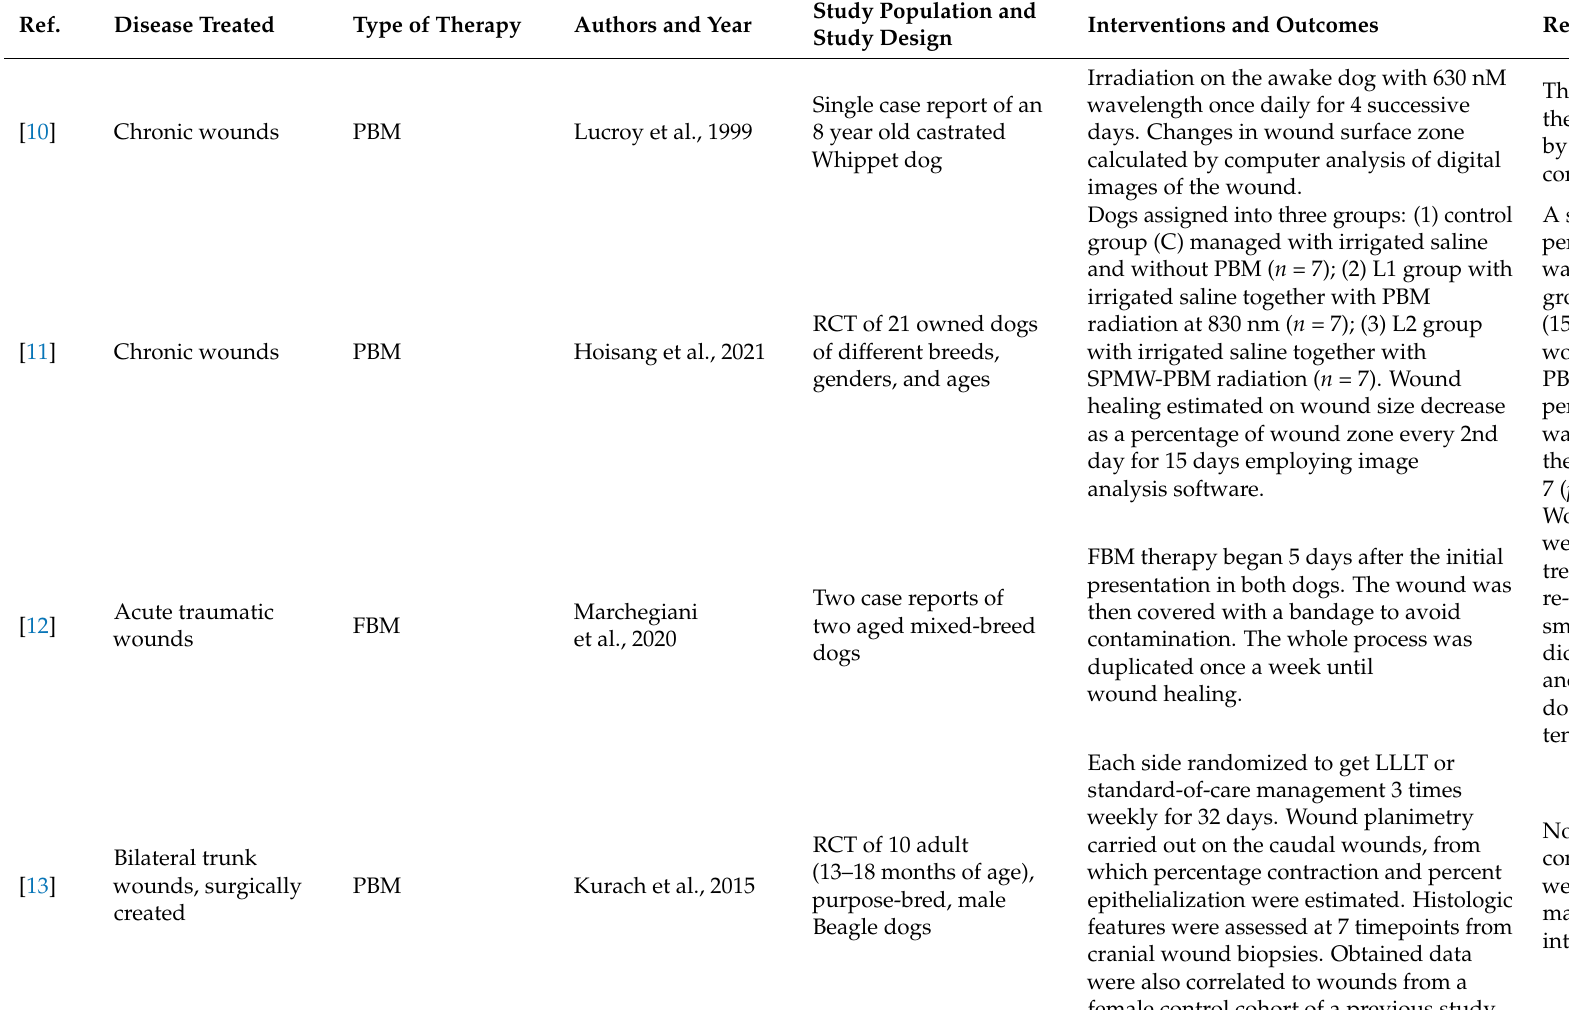
Table 1. Articles included in the critically appraised